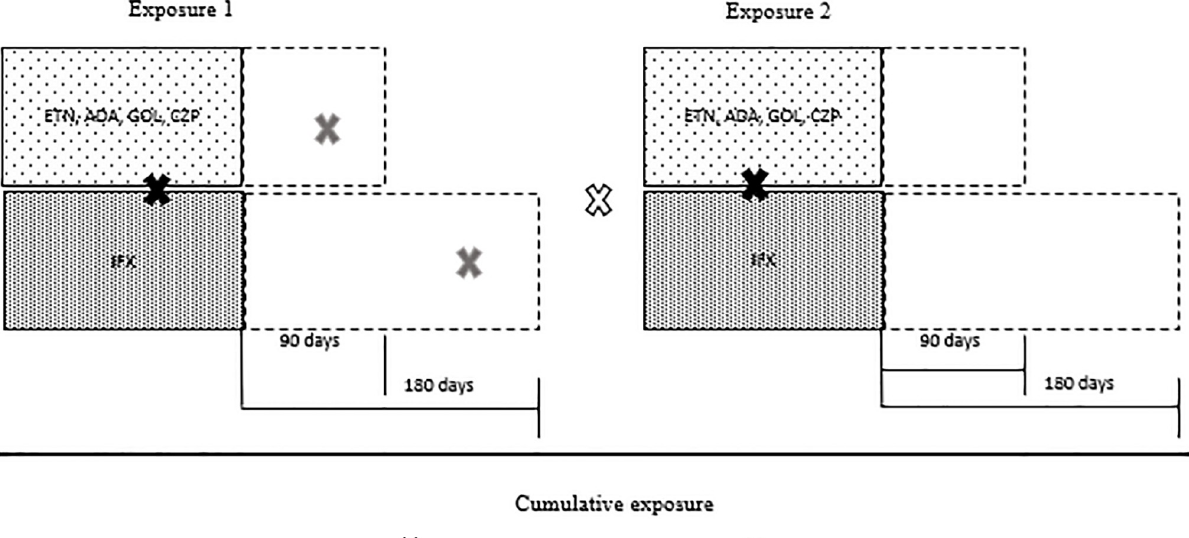
Fig 1. Model for drug-related tuberculosis cases. Cases of TB during TNF inhibitors use. Cases of TB associated with recente use of TNF inhibitors. Cases of TB not related to TNF inhibitors